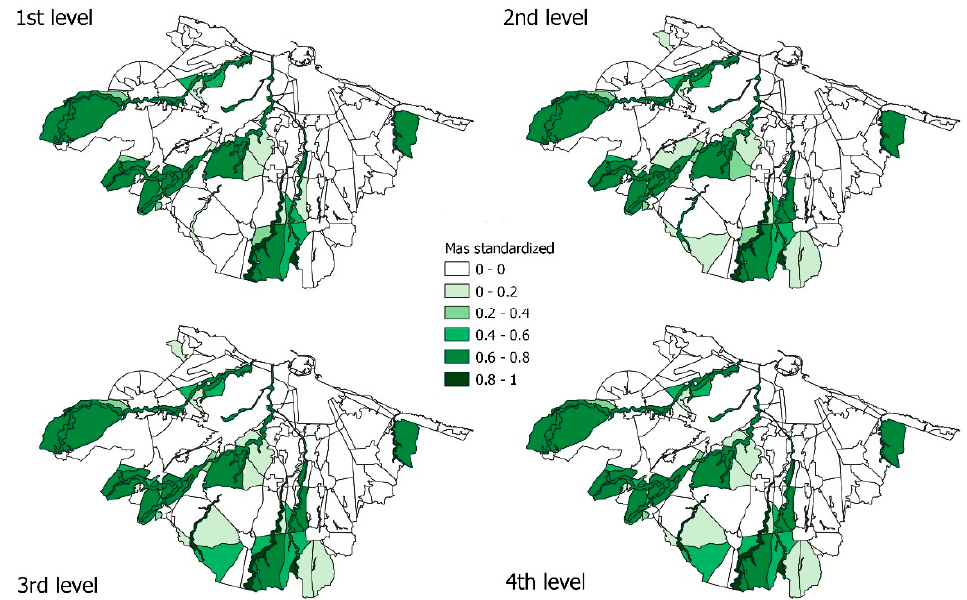
Figure 7. Asymptotic Generalized Biological Energy (M as )–standardized value. Note that each M as i is divided by the maximum M value for the specific BELU i . Table 1. Comparison between couples of scenarios at the Bio-Energy Landscape Unit (BELU) level.